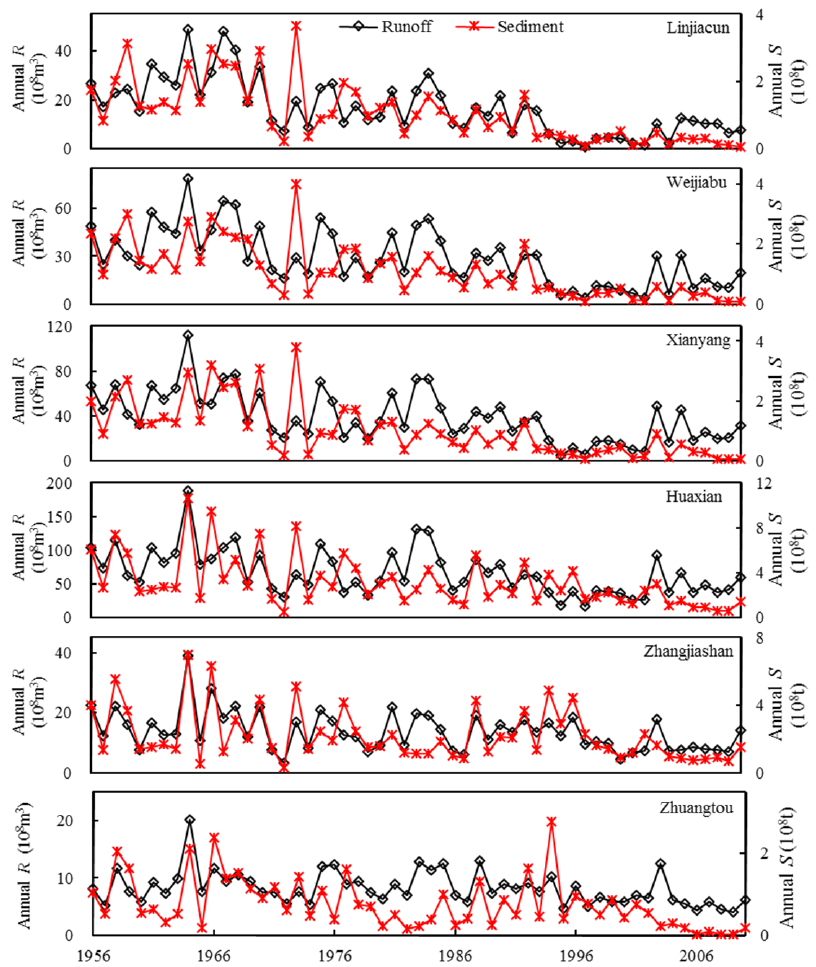
Figure 2. The annual runoff and sediment data series from six gauging stationsi n the WRB. R and S denote the runoff and sediment, respectively.